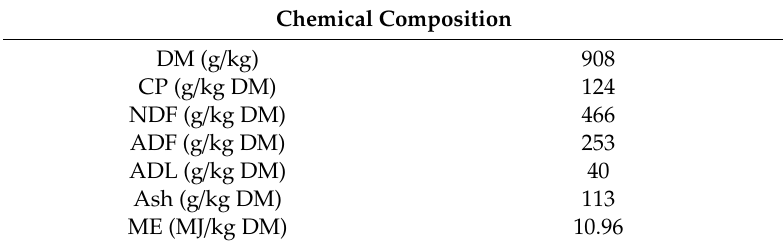
Table 1. Chemical composition of feedstu ff s used in the experiment (on an as-fed basis). Chemical